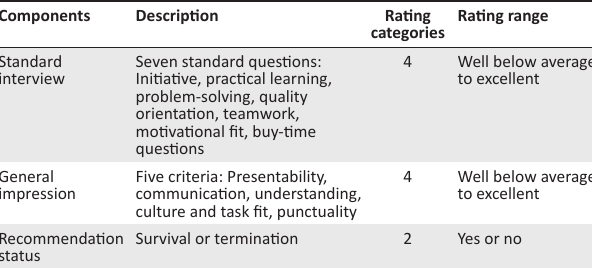
TABLE 3: Operationalisation of phase four components. Components